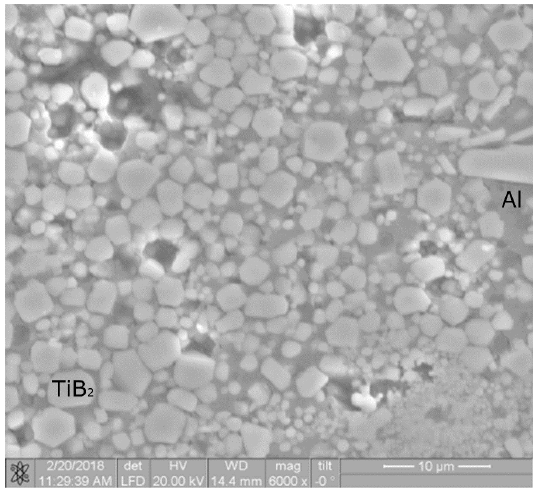
Figure 2. Structure of the Al-TiB 2 master alloy.